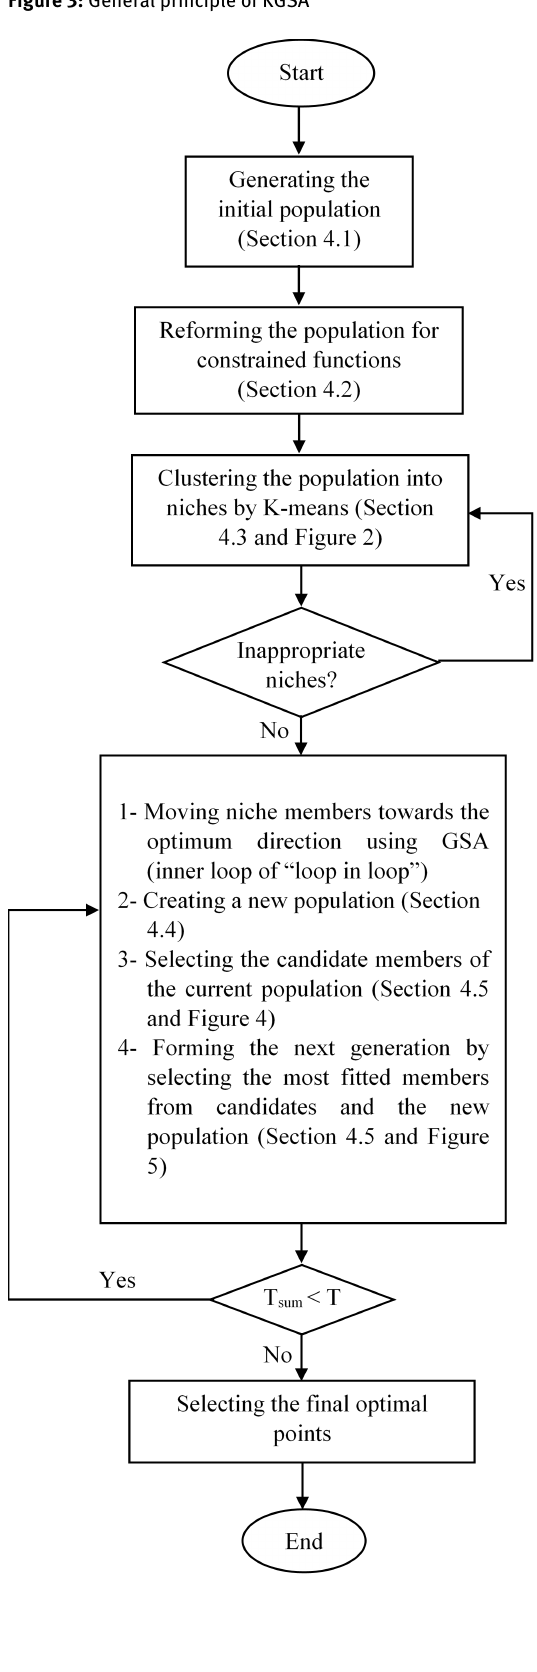
Figure 3: General principle of